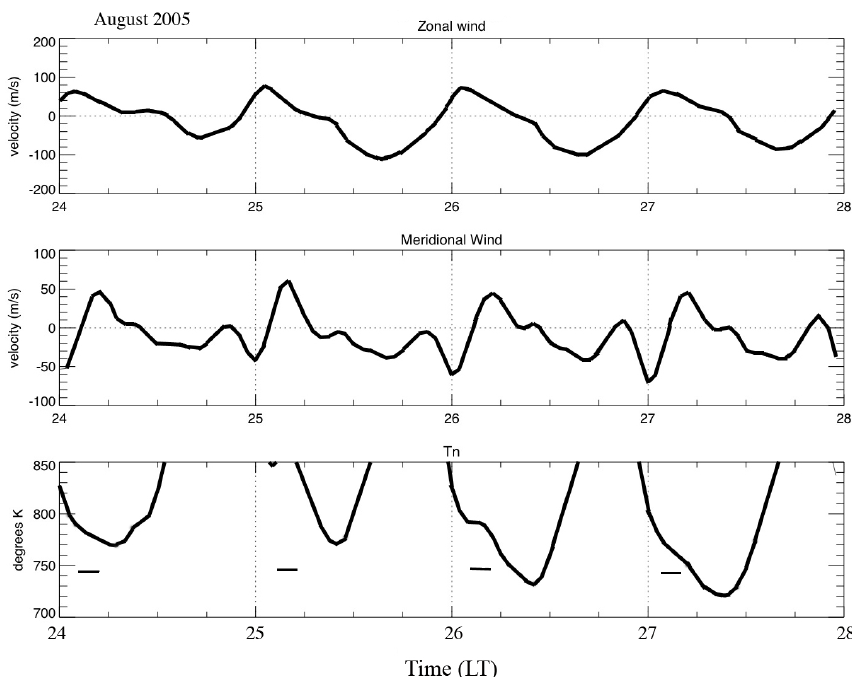
Fig. 13. NCAR TIME-GCM predictions of zonal wind (top panel), meridional wind (middle panel) and temperature (bottom panel) plotted against local time for the location of the Arequipa FPI observatory for the four days from 24 August to 28 August 2005. The horizontal black line located below the temperature plot in each panel marks the expected local time period for the MTM